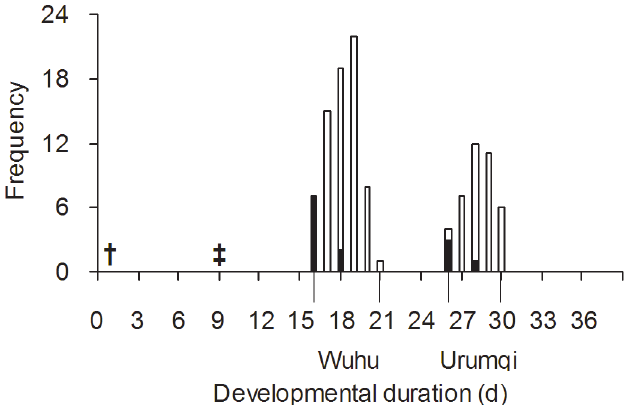
Fig 4. Developmental duration of P . vindemmiae from primary and secondary parasitism with a 9 day exposure interval. Wuhu and Urumqi strains represent the primary and secondary parasitoids, respectively. † and ‡ indicate the primary and secondary exposure, respectively. Open and solid bars indicate females and males,